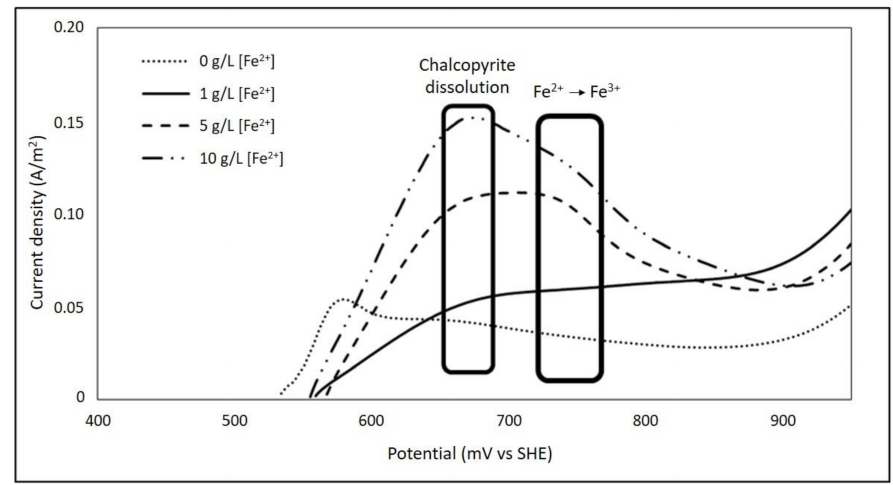
Figure 6. Effect of the concentration of ferrous ions at 0, 1, 5, and 10 g/L [Fe 2+ ] on the chalcopyrite electrode (1 mV/s) using a solution with 20 g/L [Cl − ], 0.5 g/L [Cu 2+ ], and pH 1 adjusted with sulphuric acid at 25 ◦ C.